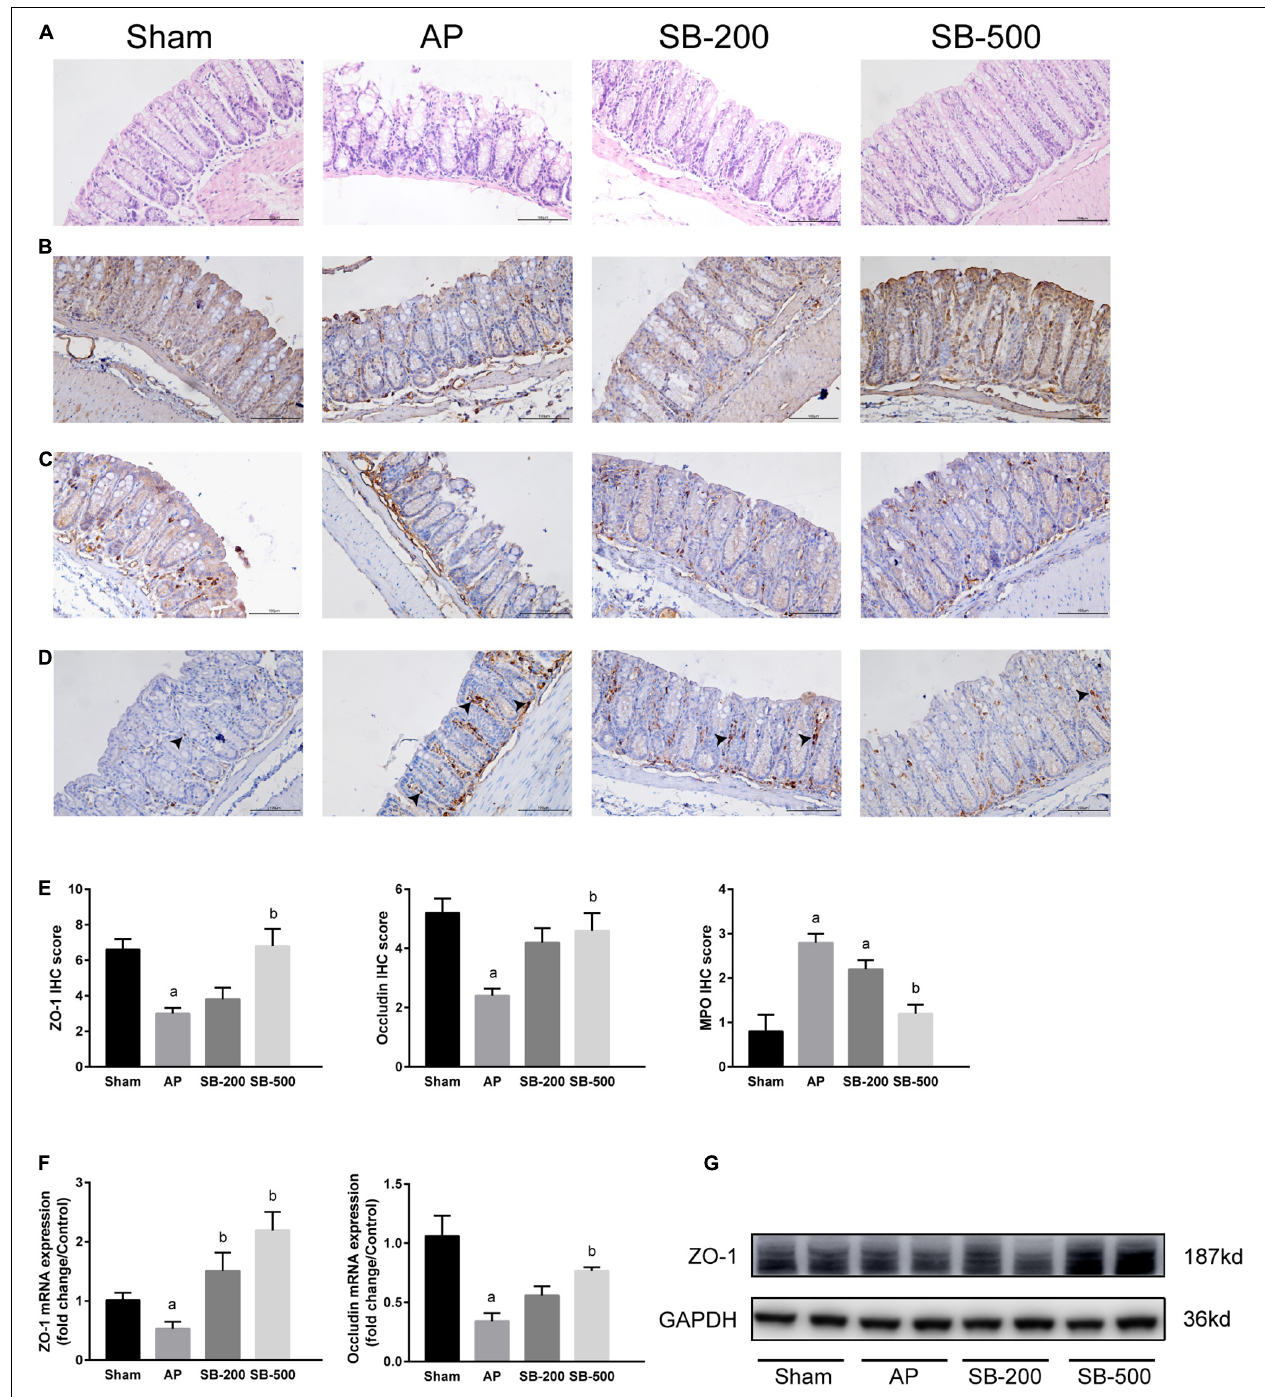
FIGURE 5 | Colonic barrier functions changes in the mice from each group. (A) HE staining of colon tissue from mice in each group ( × 200). (B) IHC staining of ZO-1 in colon tissue from mice in each group ( × 200). (C) IHC staining of occludin in the colon tissue from mice in each group ( × 200). (D) IHC staining of MPO in the colon tissue from mice in each group ( × 200). The black arrow indicates MPO positive cells. (E) IHC staining scores of ZO-1, occludin, and MPO in the colon tissue in each group. The (F) mRNA and (G) protein expression levels of ZO-1 and occludin in the colon tissues from mice in each group. n = 8. The data were presented as the mean ± standard error of the mean. a p < 0.05 vs. Sham group. b p < 0.05 vs. AP group. Sham, Sham operation group; AP, acute pancreatitis group; SB-200, 200 mg/kg butyric acid intervention group; SB-500, 500 mg/kg butyric acid intervention group; IHC, immunohistochemical staining; MPO, myeloperoxidase; HE, hematoxylin and eosin; ZO, zona